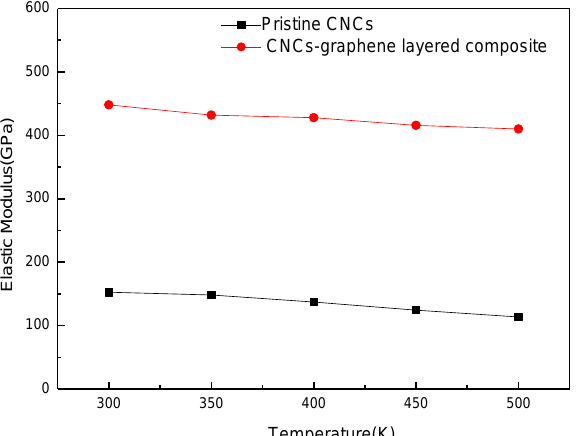
Figure 3. Comparison of elastic modulus of pristine CNCs and CNCs-graphene layered composite under different temperatures.